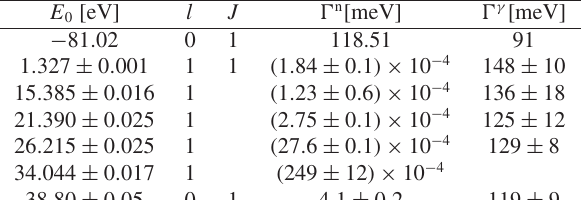
Table 1. Resonance parameters of the system 117 Sn + n [5]. E 0 denotes the resonance energy, l is the orbital angular momentum of the neutron, J is the total angular momentum, (cid:7) n is the neutron width, and (cid:7) γ is the γ width.